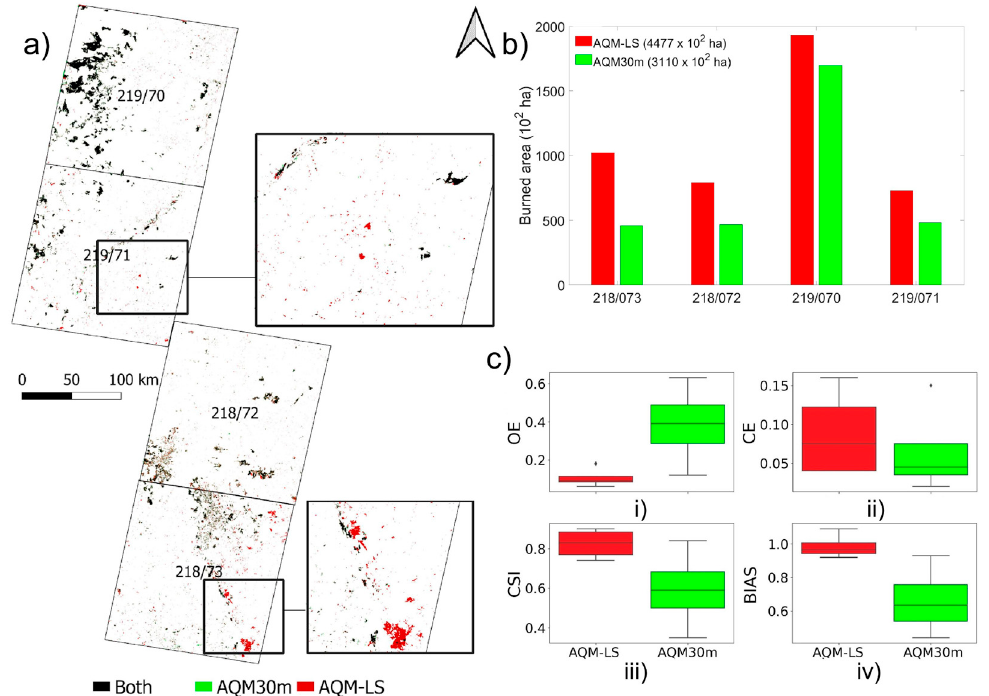
Figure 2. (a) Fire scars as detected by AQM-LS (red), AQM30m (green) and by both products (black) for the period and regions depicted in Table 1. Gray polygon shows the four Landsat scenes boundary. (b) Total amount of burned area (×10² ha) as detected by BA products for each Landsat scene. Numbers in parentheses denote the total amount of burned area for all Landsat scenes. (c) Validation metrics: (i) Omission errors (OE), (ii) Commission errors (CE), (iii) Critical Success Index (CSI), and ( iv) Bias (BIAS) for AQM-LS (red) and AQM30m (green) products in all Landsat scenes.